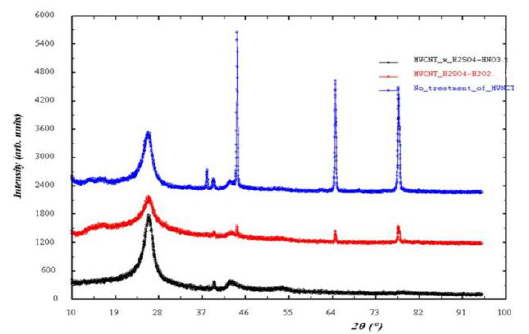
Figure 4. X-ray diffraction patterns of untreated MWCNT (1) and treated MWCNT with sulfuric acid /hydrogen peroxide (2) and sulfuric acid/nitric acid (3)